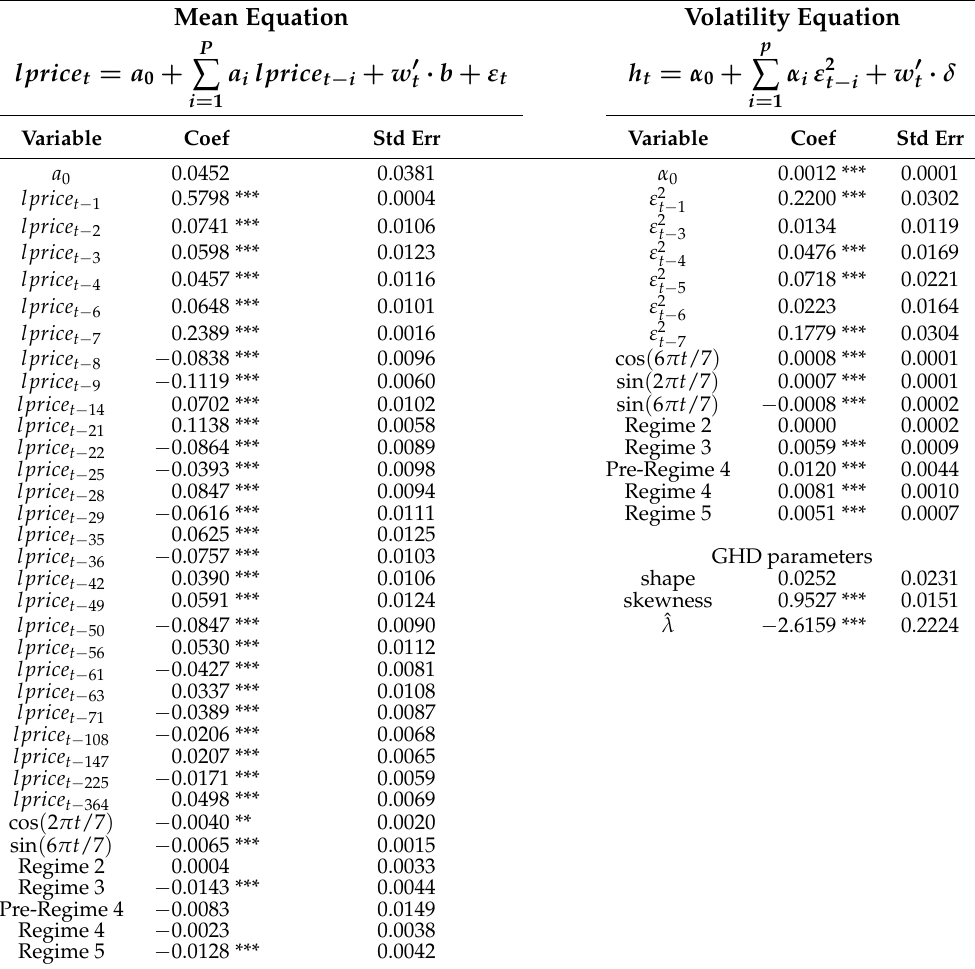
Table A5. Estimation results when assuming